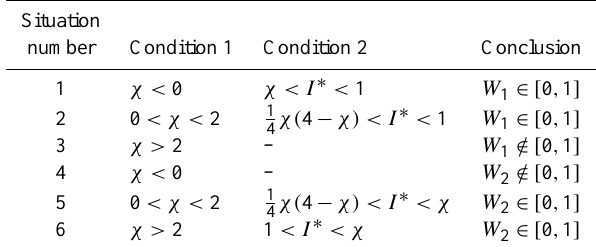
Table 1. Conditions on the parameters κ,D ∗ ,I ∗ for the existence of W 1 ∈ [ 0 , 1 ] or W 2 ∈ [ 0 , 1 ] (see Eq. 19); for simplification, we use χ = κ(D ∗ − I ∗ ) , a measure of the difference between the con- vergence and the rate of soil moisture change, scaled by all other process parameters. If situations 1 and 5 occur jointly with W 0 < W 2 , then the solution is not physically realistic for all x > 0 (see Sect.